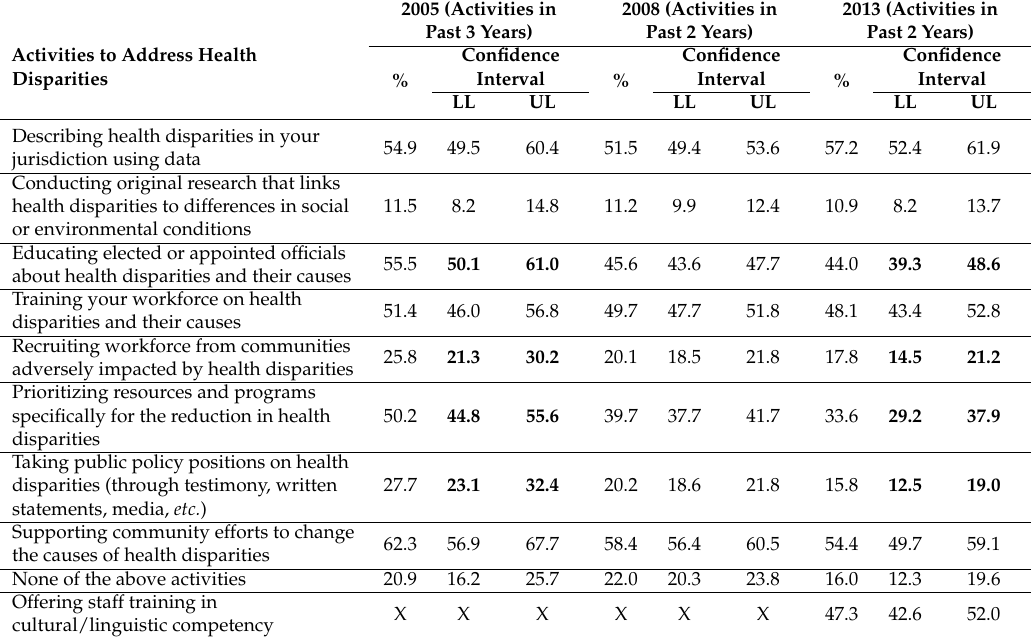
Table 2. Percent of LHDs conducting specific activities to address health disparities, 2005, 2008, and